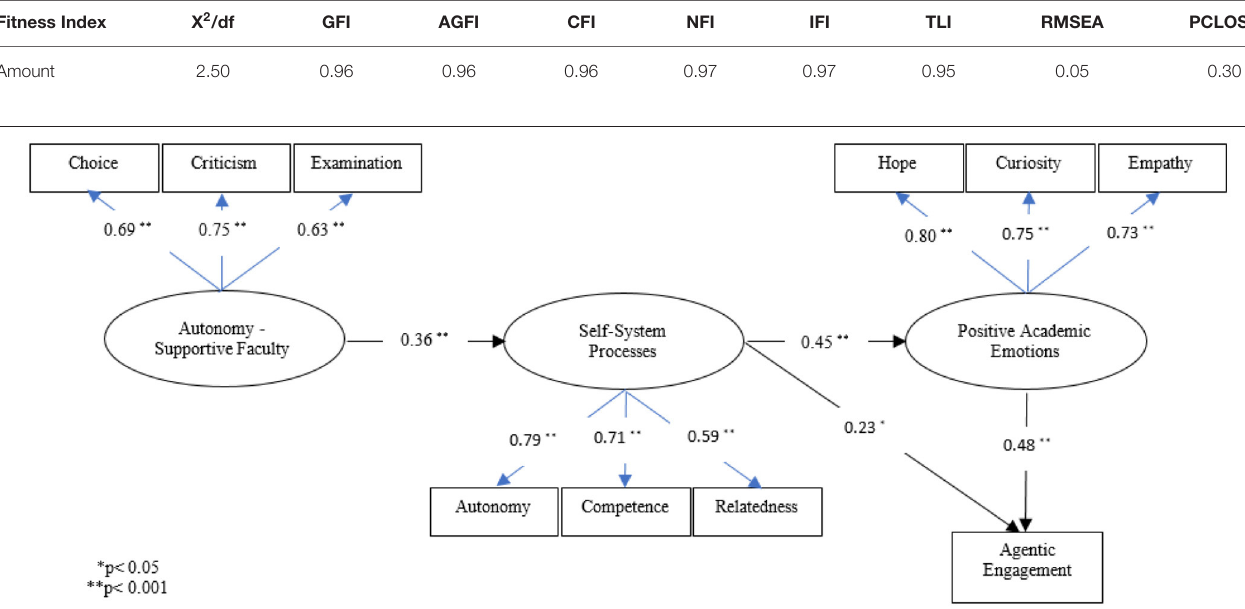
TABLE 2 | Model fit indices.